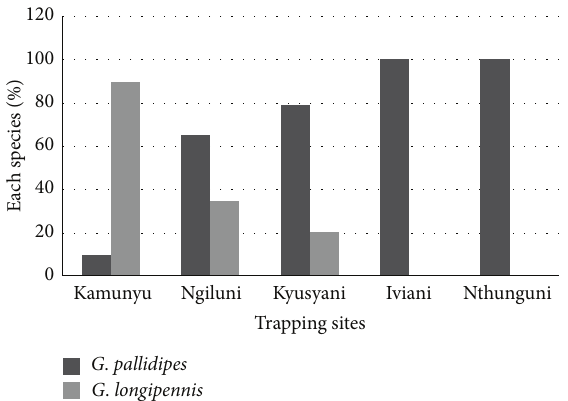
Figure 4: Distribution of Glossina species captured from study sites in Mtito Andei Division.